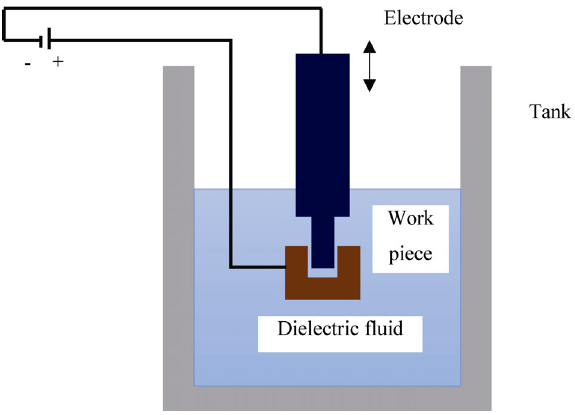
Fig. 27 Schematic diagram of micro-electrical discharge machining (µEDM).